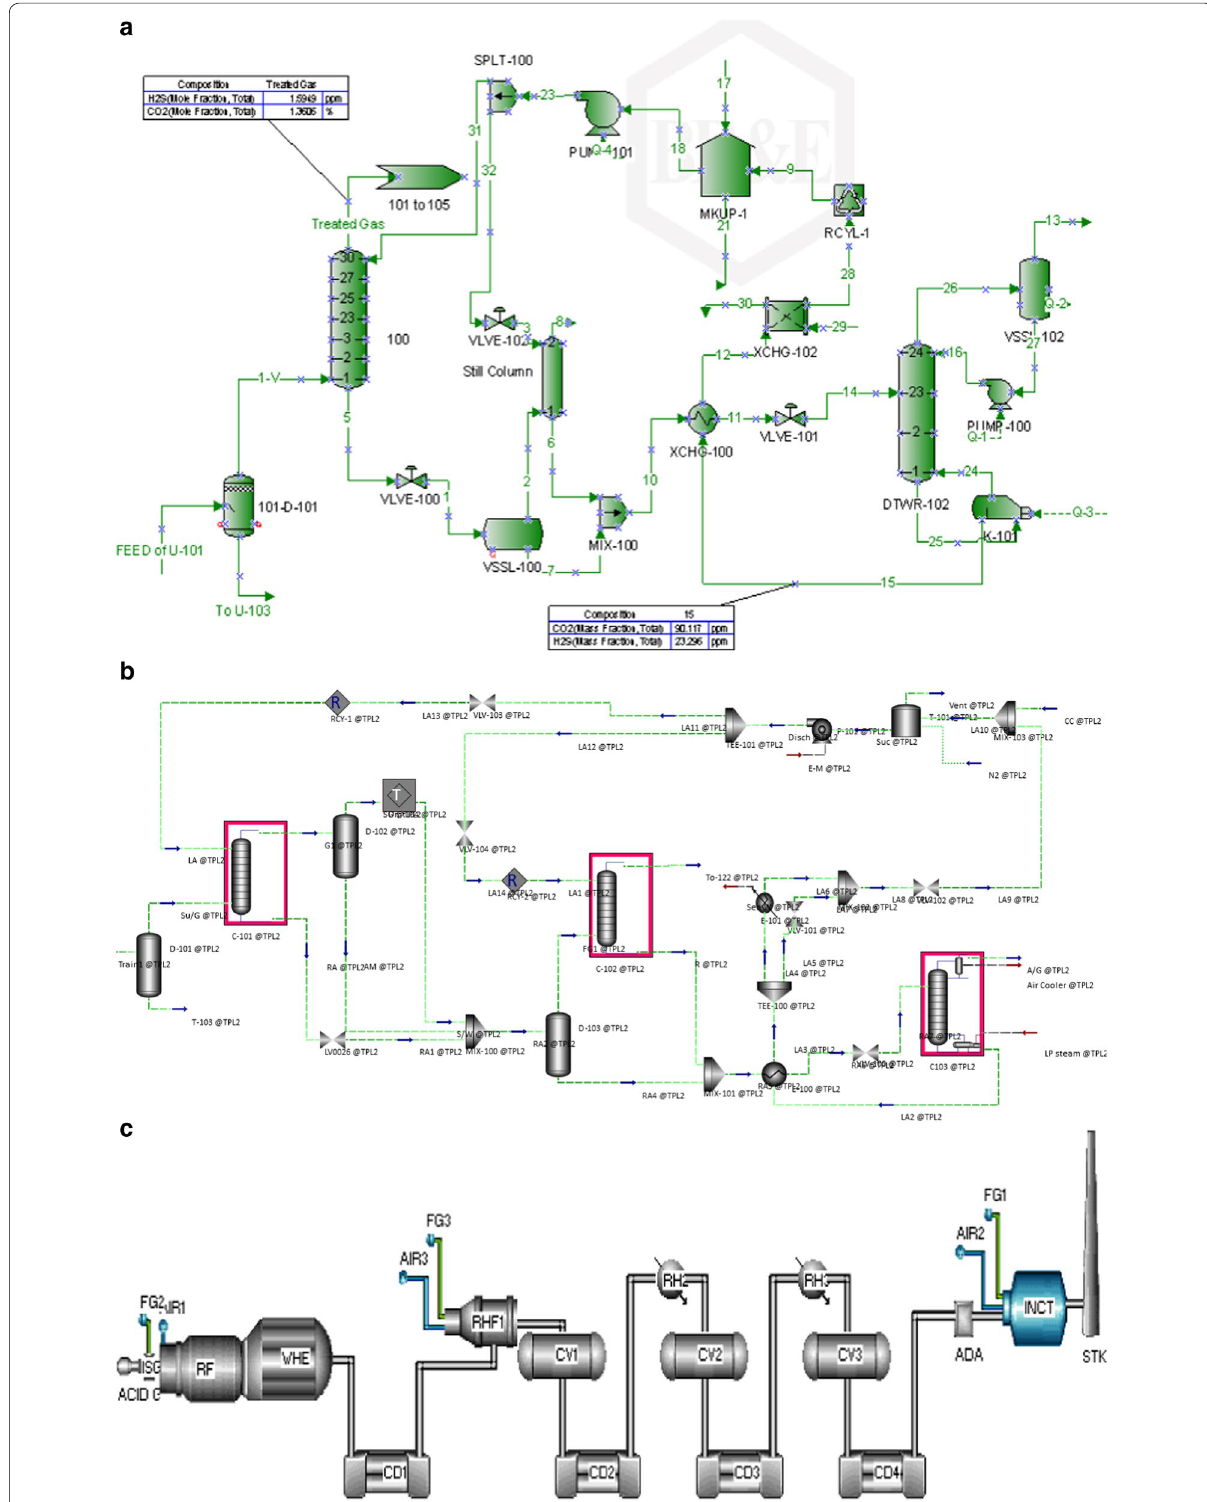
Fig. 2 Schematic of the simulated gas sweetening unit [unit 101 of phases 2 and 3 in South Pars Gas Field (Asalouyeh, Iran)] as from a ProMax, b Aspen HYSYS and c SULSIM